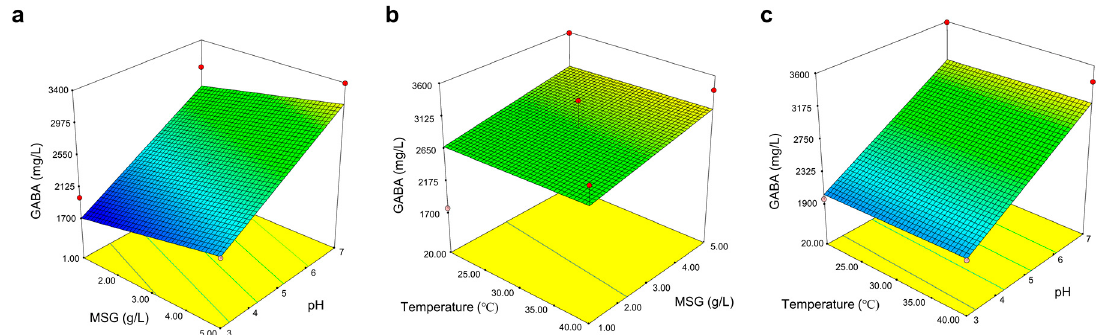
Figure 5. Response surface profile of GABA production from B. cereus KBC indicated the effects between ( a ) MSG and pH, ( b ) temperature and MSG, and ( c ) temperature and pH.